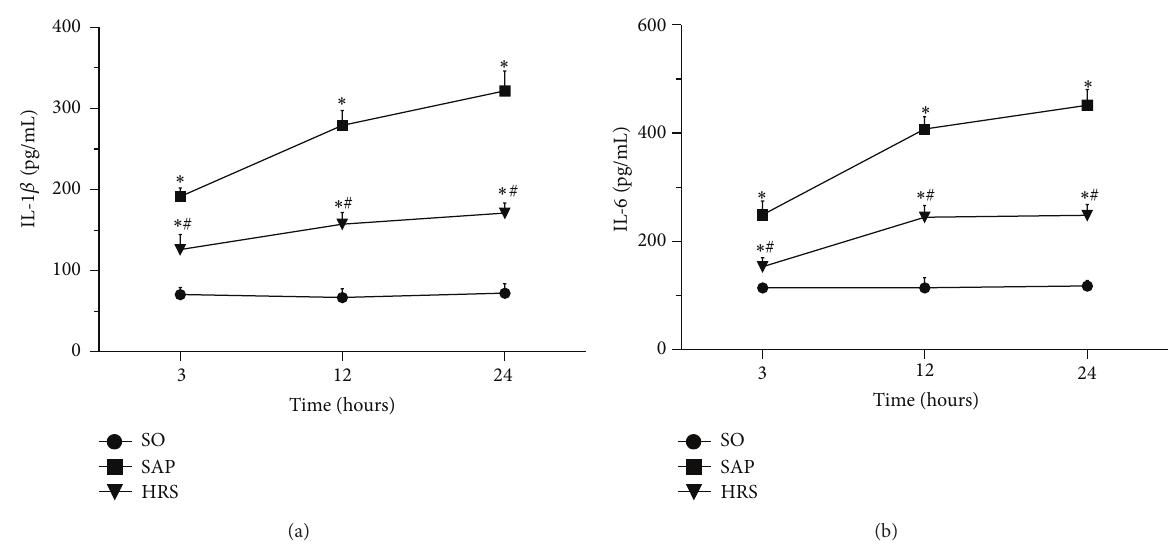
Figure 6: Effects of hydrogen-rich saline reduced proinflammatory cytokines. Serum levels of IL-1 𝛽 and IL-6 were quantified by ELISA at different time points after SAP. (a) Serum IL-1 𝛽 Level, (b) serum IL-6 level. Results are expressed as mean (SD), 8 rats per group. ∗ 𝑃 < 0.05 versus SO group; # 𝑃 < 0.05 versus respective SAP group.